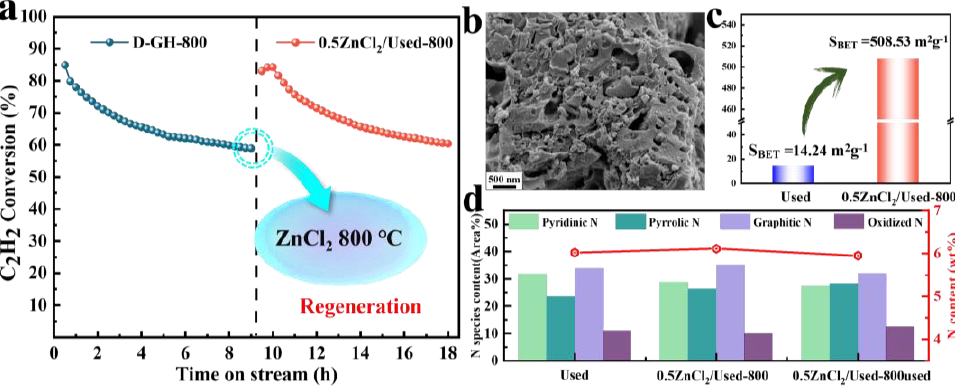
Figure 5. ( a ) The catalytic stability of D-GH-800 and 0.5ZnCl 2 /Used-800. Reaction conditions: T = 180 °C, C 2 H 2 = 180 h − 1 , V HCl /V C2H2 = 1.15. ( b ) SEM image of 0.5ZnCl 2 /Used-800 catalysts. ( c ) The specific surface area data of Used and 0.5ZnCl 2 /Used-800 catalysts. ( d ) The pyridinic-N, pyrrolic-N, gra- phitic-N, and oxidized N content on N 1s XPS spectra of D-GH-800, 0.5ZnCl 2 /Used-800 and 0.5ZnCl 2 /Used-800 catalysts.